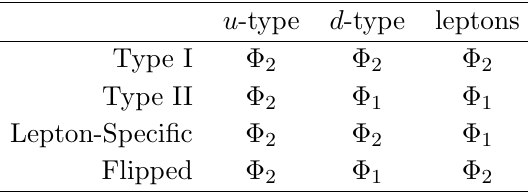
Table 1 . The four Yukawa types of the softly broken Z